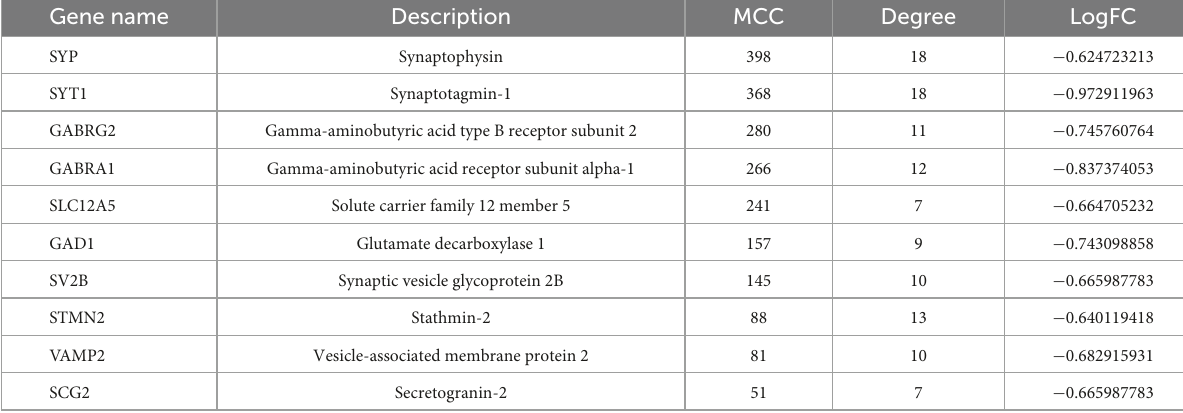
TABLE 4 Cytohubba